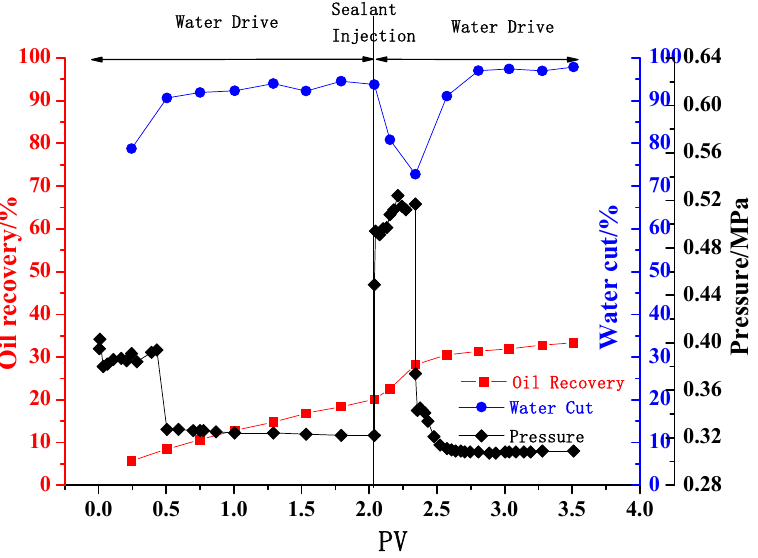
Figure 11. Production curve of heterogeneous model.